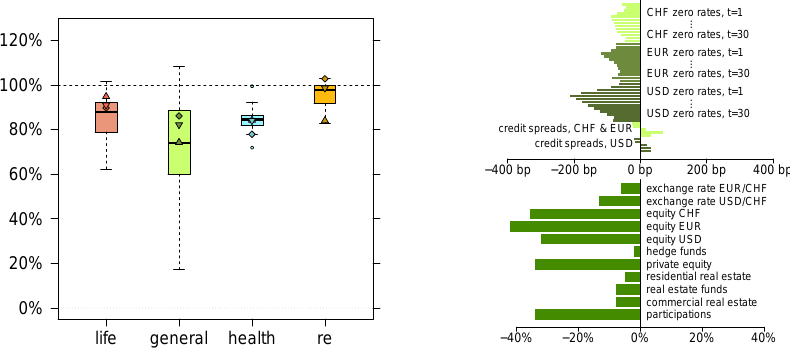
Figure 9. (rhs) illustrates the changes in market risk factors corresponding to the stock market crash of 2000/2001, see FINMA [37]. (lhs) illustrates the resulting impact ratios (cid:36) i of the insurance companies, where (cid:78) , (cid:7) and (cid:72) correspond to the impact ratios of the first, second and third largest company, respectively, in each branch of